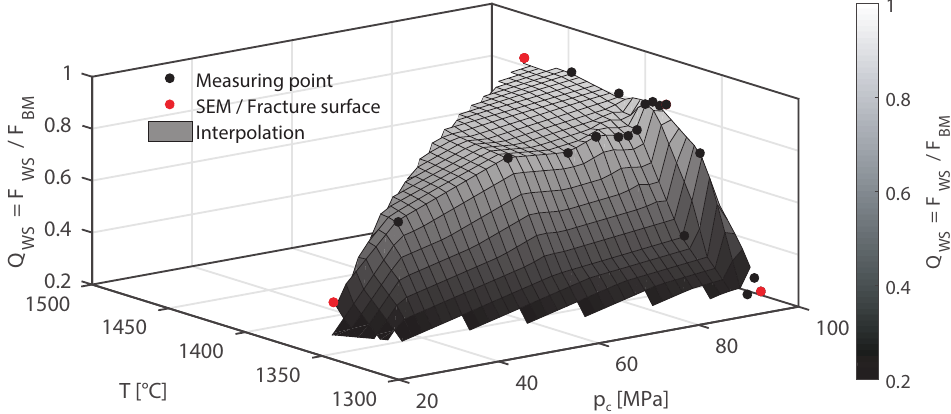
Figure 10. Dependence of the weld seam strength ratio Q WS on temperature T and contact normal stress p c , established in the bending test with hardened